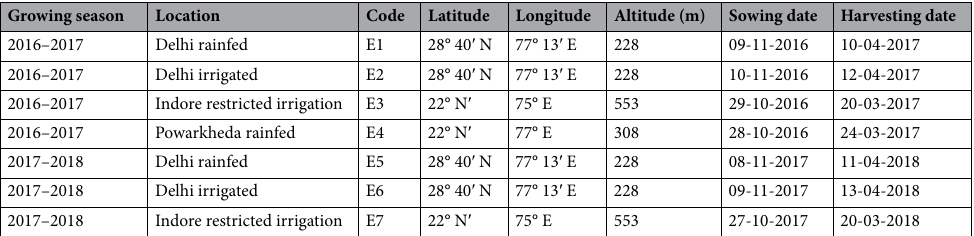
Table 1. Characteristics of the studied environments, period of the experiments in each field trial.